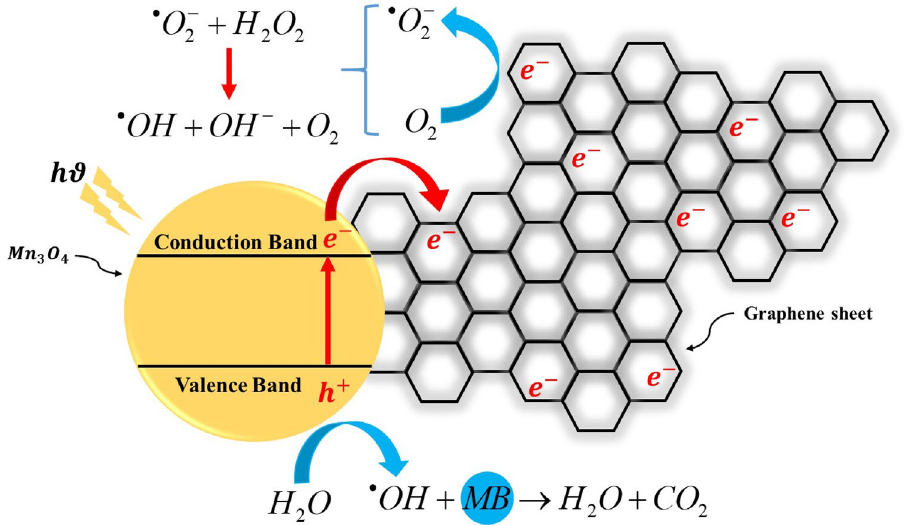
Fig. 13 Schematic of a Mn O /x%GO 3 4